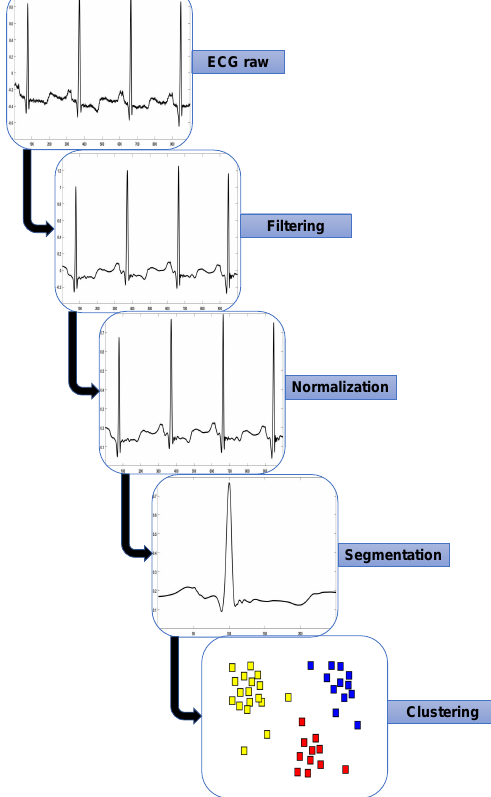
Figure 3. Diagram of